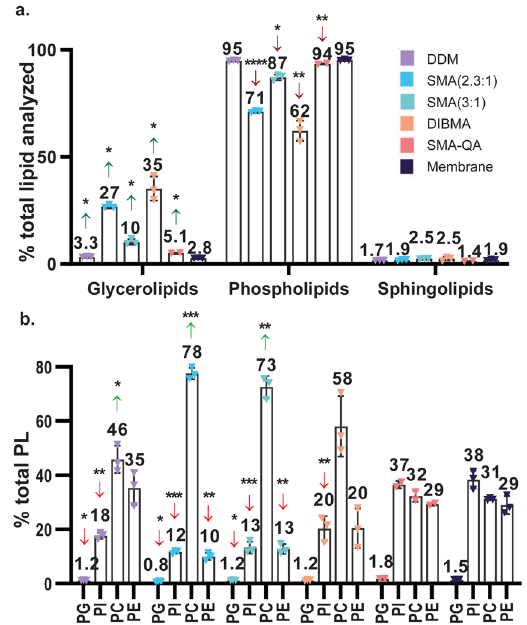
Fig. 4 Lipid composition of solubilized membranes and membrane pellet of Jurkat cells analyzed by LC-MS/MS, which allowed for GL, PL, and SL identi fi cation. a Jurkat cell lipid composition. Lipid class distribution in each solubilized sample compared with the membrane pellet. b Jurkat cells headgroup distribution of PL species. Data points correspond to three technical replicates, except for technical duplicates for SMA-QA. Error bars represent ±S.D. Signi fi cant differences (upon one-way ANOVA) are denoted as * p < 0.05, ** p < 0.01, *** p < 0.001, **** p <